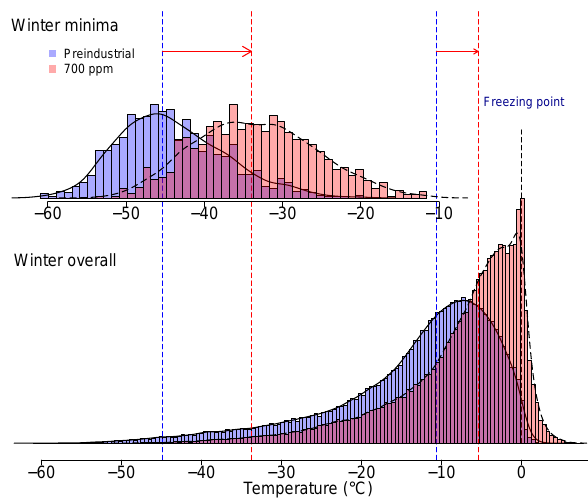
Figure 1. Wintertime (December–February) temperatures from a location in Idaho from 1000-year CCSM3 model runs under pre- industrial and 700ppm CO 2 levels. Bottom: marginal distributions of daily minimum temperatures in winter. Top: distributions of winter seasonal minima. Note: (1) in both climate states, the dis- tributions of seasonal minima are skewed to the right, whereas their marginal distributions are skewed to the left; (2) in the fu- ture warmer climate state, variation in the marginal distribution de- creases but variation in the seasonal minima increases; and (3) the median of the distribution of seasonal minima increases more than the median of the marginal distribution. We use seasonal instead of annual minima in this example so that the marginal and extreme distributions are based on the same data. The analogous plot for summertime maxima at this location is shown in Appendix Fig.